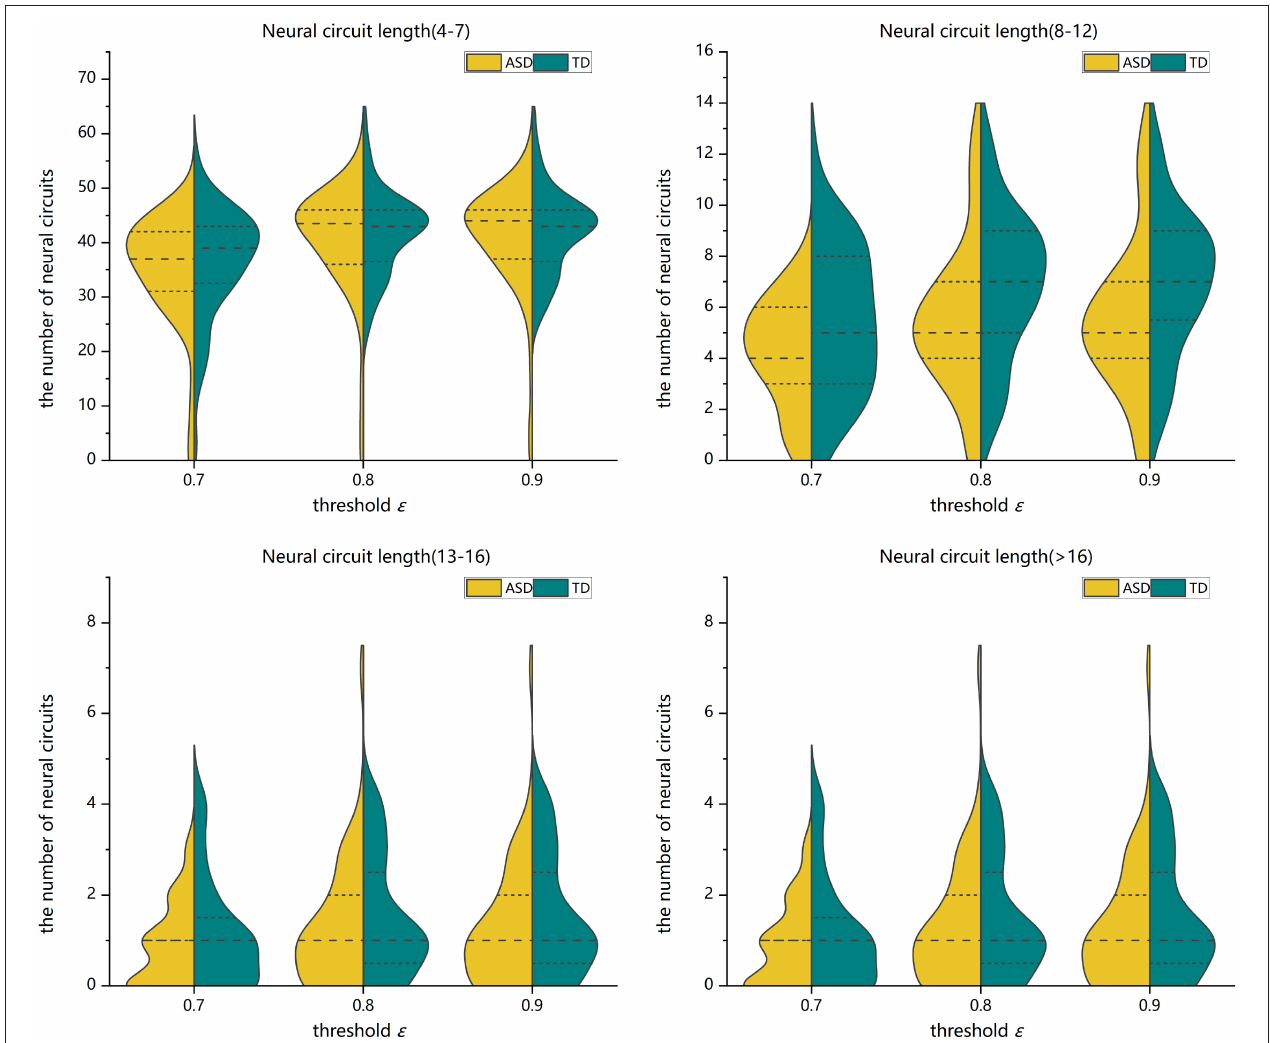
FIGURE 7 | Violin pictures of the comparison of the numbers of FC neural circuits with different circuit length ranges of the two groups.